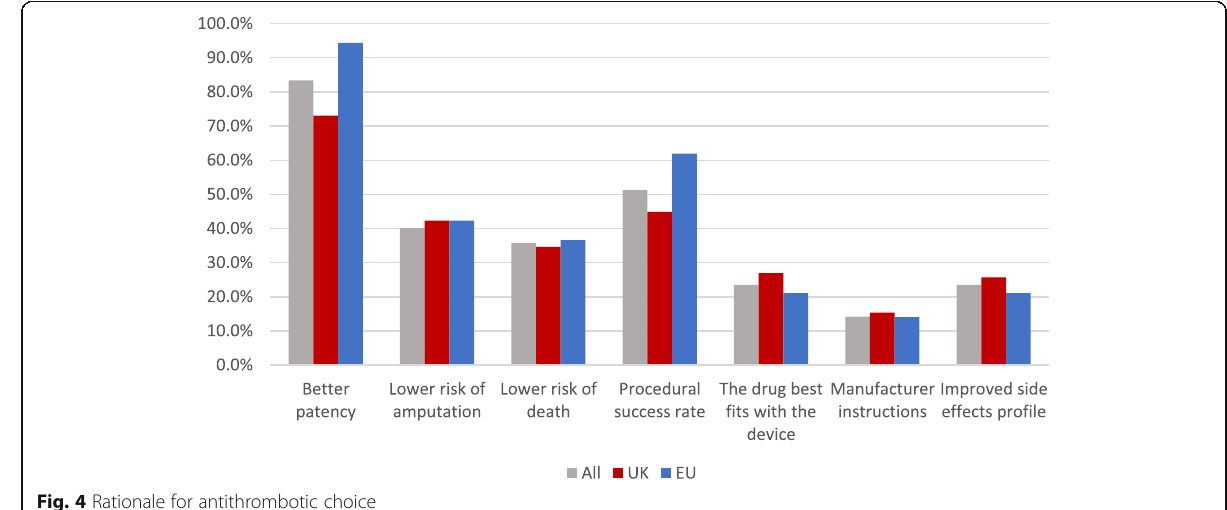
Fig. 4 Rationale for antithrombotic